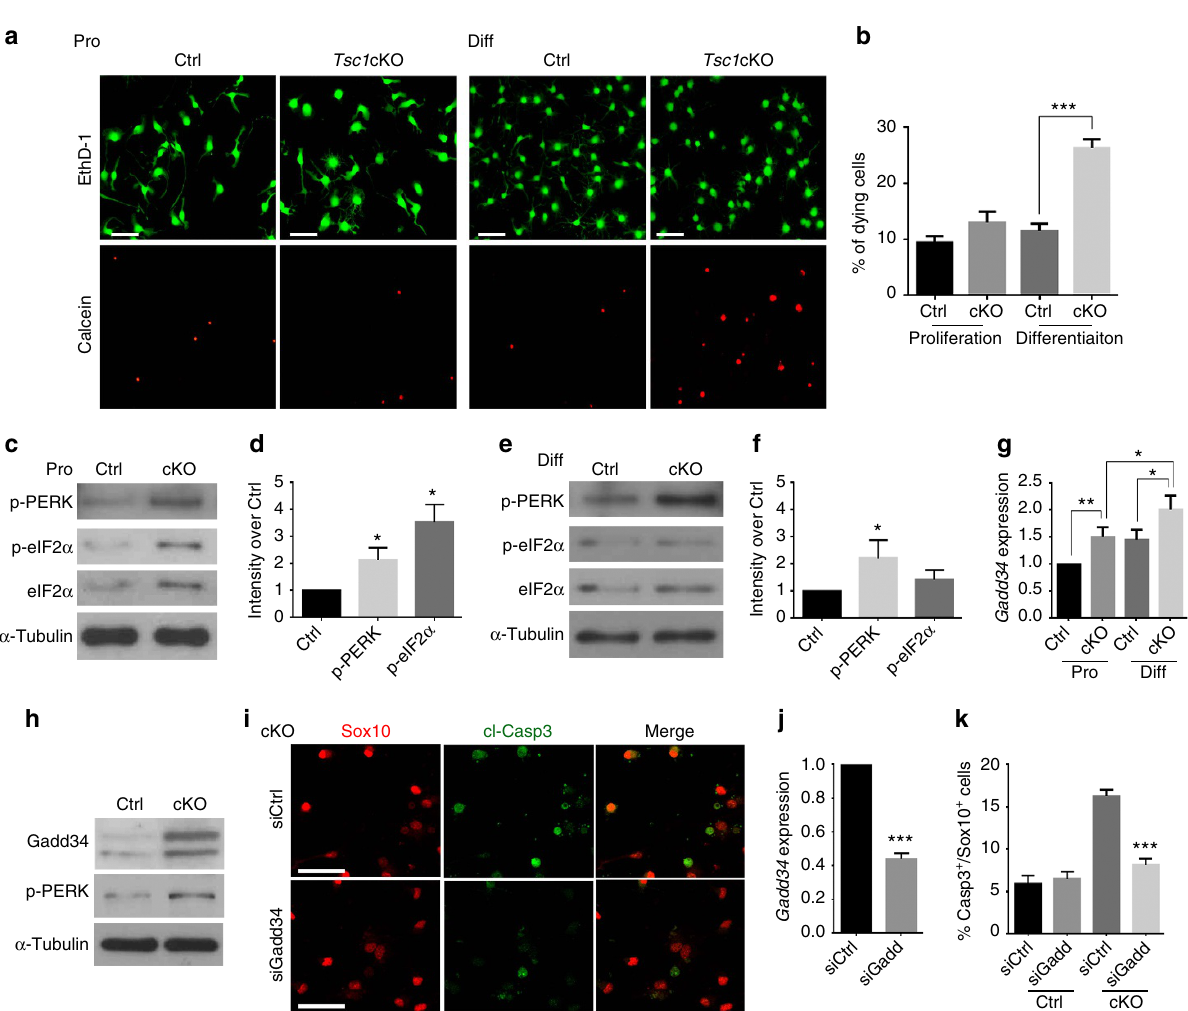
Figure 7 | Elevation of adaptive stress responses enhances OL survival. ( a ) OPCs from control and Tsc1 cKO mutants at P5 were cultured in PDGFAA proliferation (Pro) or T3 differentiation media (Diff) for 24h and stained with EthD-1 and Calcein AM. Corresponding upper and lower panels were taken in the same field. Scale bar, 50 m m. ( b ) The percentage of dying cells among OPCs isolated from control and Tsc1 cKO mutants in proliferation or differentiation medium for 24h. Data represent the mean ± s.e.m. from three independent experiments; *** P o 0.001, Student’s t- test. ( c – f ) Primary OPCs from control and Tsc1 cKO pups were cultured under ( c , d ) proliferation or ( e , f ) differentiation conditions for 24h. The cell lysates were subject to western blot analysis using antibodies to p-PERK, p-eIF2 a and eIF2 a ; a -tubulin: loading control. p-eIF2 a and p-PERK levels were normalized to a -tubulin. The graphs in d and f depict the fold change of expression levels in Tsc1 cKO over control cells (data represent the mean ± s.e.m. from three independent experiments). * P o 0.05; Student’s t -test. ( g ) qRT–PCR of Gadd34 from control and Tsc1 cKO OPCs under proliferation or differentiation conditions for 24h. Data represent the mean ± s.e.m from three independent experiments. * P o 0.05; ** P o 0.01; Student’s t -test. ( h ) Expression of Gadd34 and p-PERK in the spinal cord of control and Tsc1 cKO mice at P14 was examined by western blot. a -Tubulin was used as loading control. ( i ) Primary OPCs from control and Tsc1 cKO mice were treated with Gadd34 siRNA or scramble control siRNA 24h and immunostained with antibodies to cl-Casp3 and Sox10. Scale bar, 25 m m. ( j ) qRT–PCR analysis of Gadd34 mRNA expression from OPCs transfected with Gadd34 siRNA or scramble control siRNA for 48h. ( k ) Percentage of cl-Casp3 þ Sox10 þ cells from above-treated OPCs in i . Data represent the mean ± s.e.m from three independent experiments. *** P o 0.001; one-way analysis of variance test with Tukey’s multiple-comparison test. PDGFR a þ OPCs or CC1 þ OLs in control mice (Fig. 8d–f), or alter the proliferative capacity of Ki67-expressing OPCs in the cortex of both control and Tsc1 mutants (Fig. 8g). In contrast, guanabenz treatment resulted in a significant increase in the number of CC1 þ OLs and PDGFR a þ OPCs compared with vehicle treatment in Tsc1 cKO mice (Fig. 8d–f). The extent of myelination assayed by MBP immunostaining and western blot in the cortex was enhanced in guanabenz-treated Tsc1 -mutant mice (Fig. 8h,i). These in vitro and in vivo observations indicate that elevation of p-eIF2 a by guanabenz treatment protects OLs from cell death and restores myelination at least partially in the absence of Tsc1. NATURE COMMUNICATIONS|7:12185|DOI: